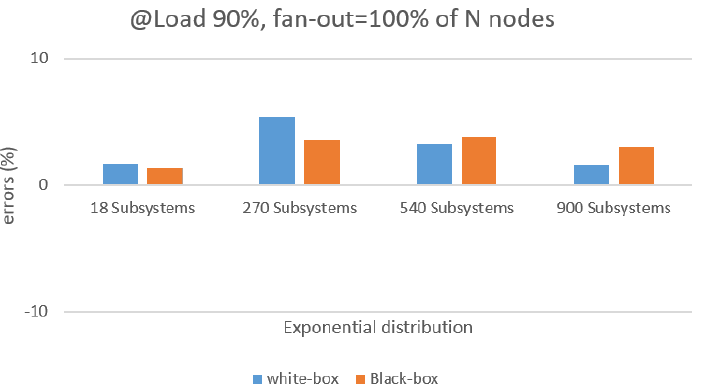
Figure 2. HFJQNs of different node utilizations, where the black-box approach is used in solution, and the load level (here) is determined by max node utilization.